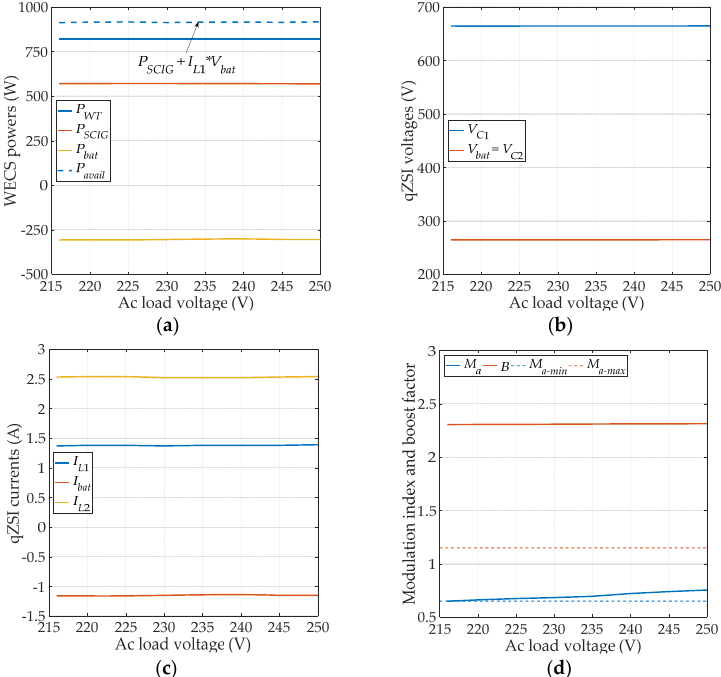
Figure 10. Steady-state characteristics for ac load voltage variation ( v w = 9 m/s, V dc = 400 V): ( a ) WECS powers; ( b ) qZSI voltages; ( c ) qZSI currents; ( d ) modulation index and boost factor.